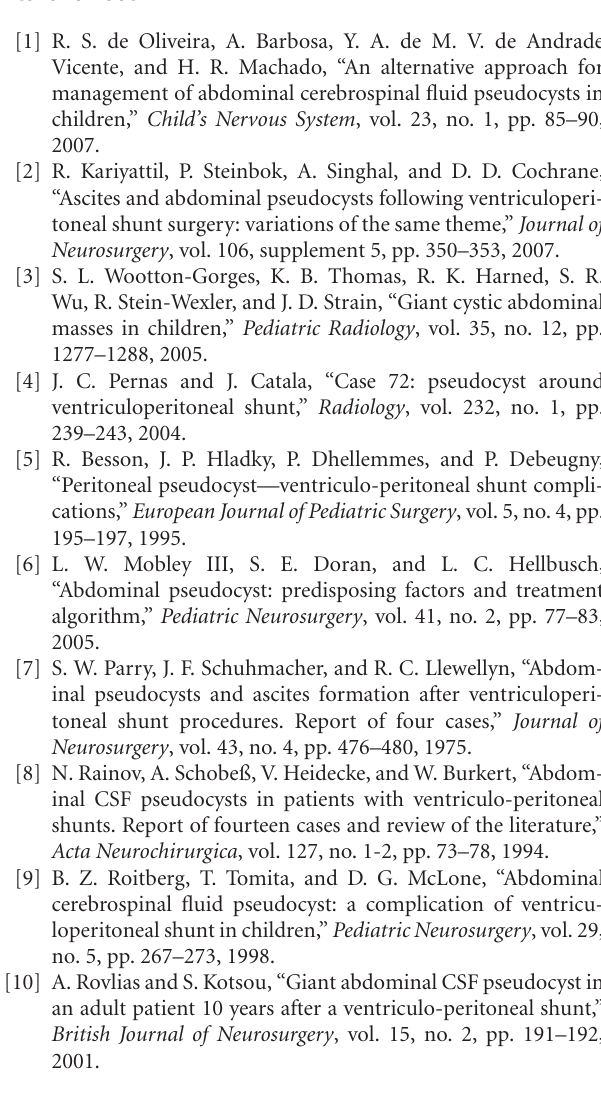
Abscess, Teratoma, Necrotic or cystic changes in tumors CSF pseudocyst, Sacrococcygeal